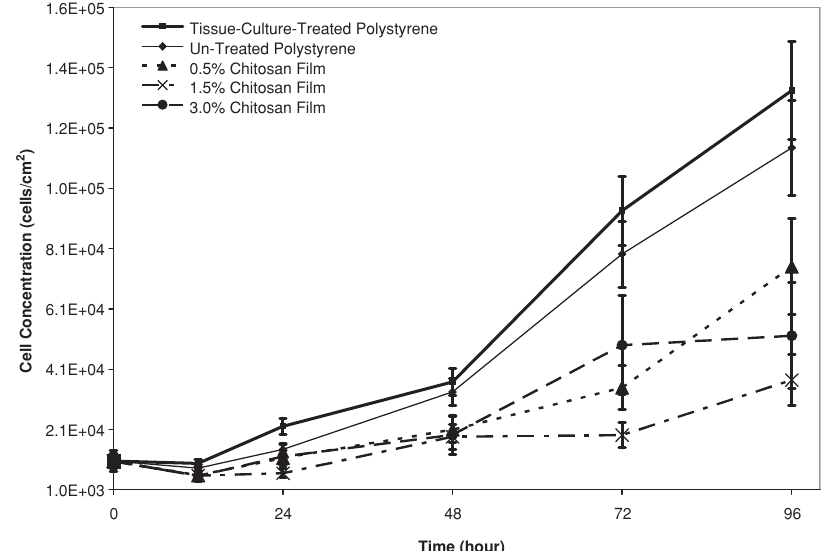
Figure 4 Cell growth on chitosan films and polystyrene controls. Each point represents three different tests, sampled in duplicate. Error bars represent 95% confidence